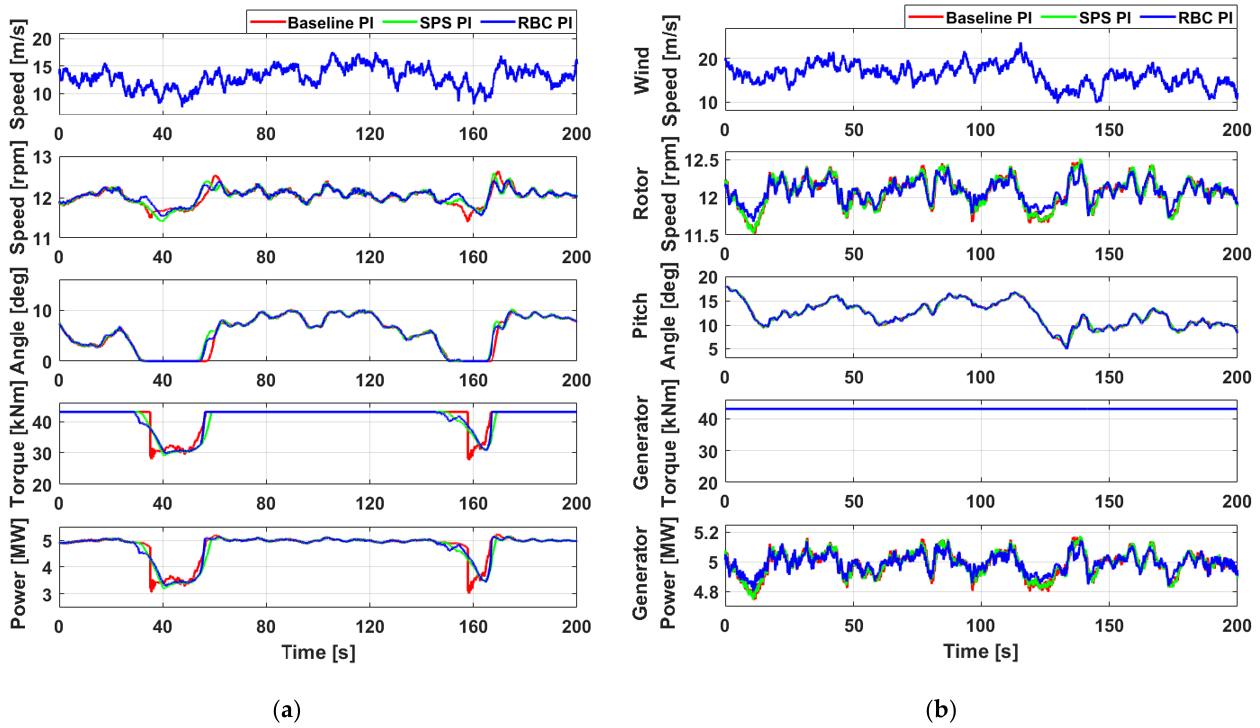
Figure 12. Results from HILS testing of NREL 5MW wind turbine for comparison of baseline PI, SPS PI, and RBC PI control performance: ( a ) average wind speed of 13 m/s and 19% turbulence intensity; ( b ) average wind speed of 18 m/s and 17% turbulence